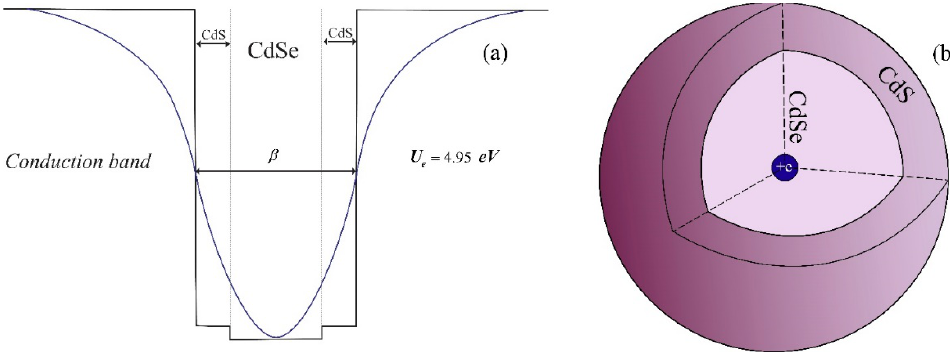
Figure 1. Structure of the conduction band of CdSe/CdS core/shell QDs ( a ), and a 3D drawing of a CdSe/CdS core/shell QD ( b ).